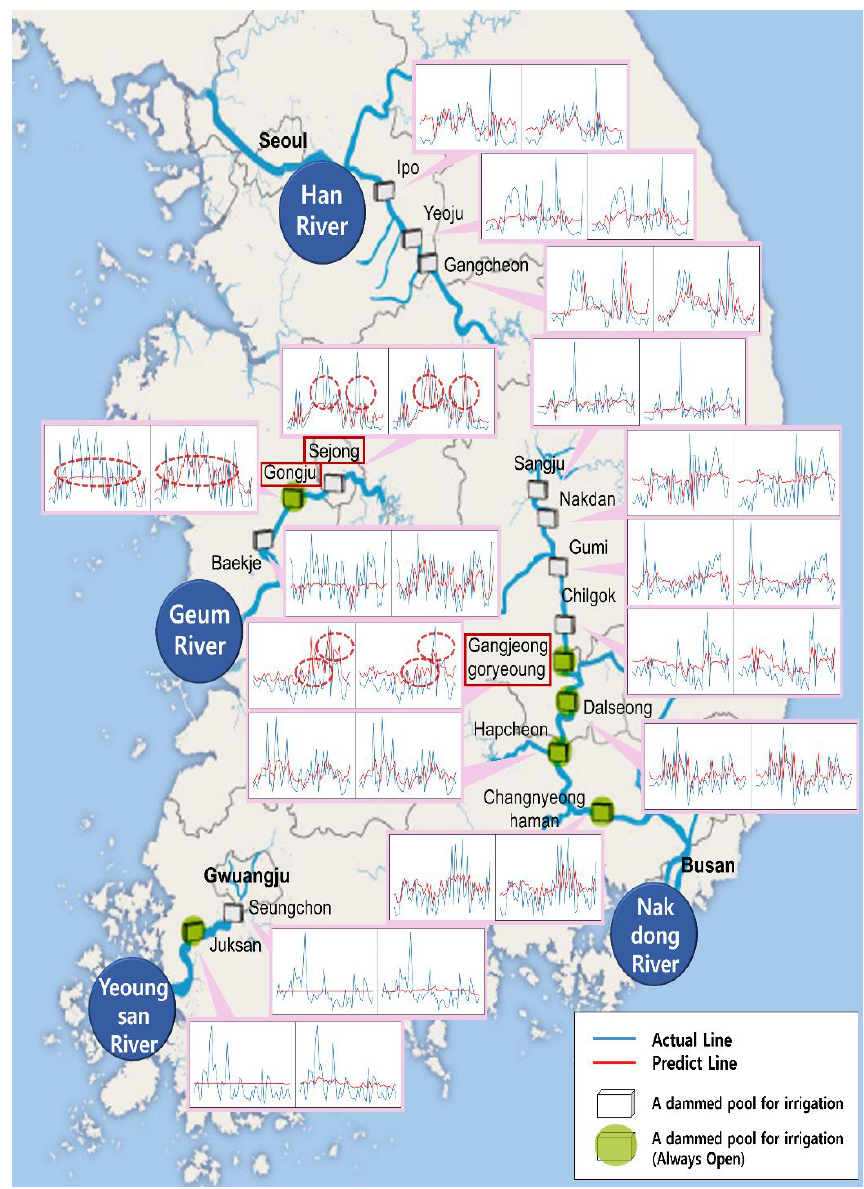
Figure 4. Comparison of MLP (left) and LSTM (right) model results for chlorophyll-a at South Korean dammed pools sites. Blue lines show actual values and red lines show predicted values.